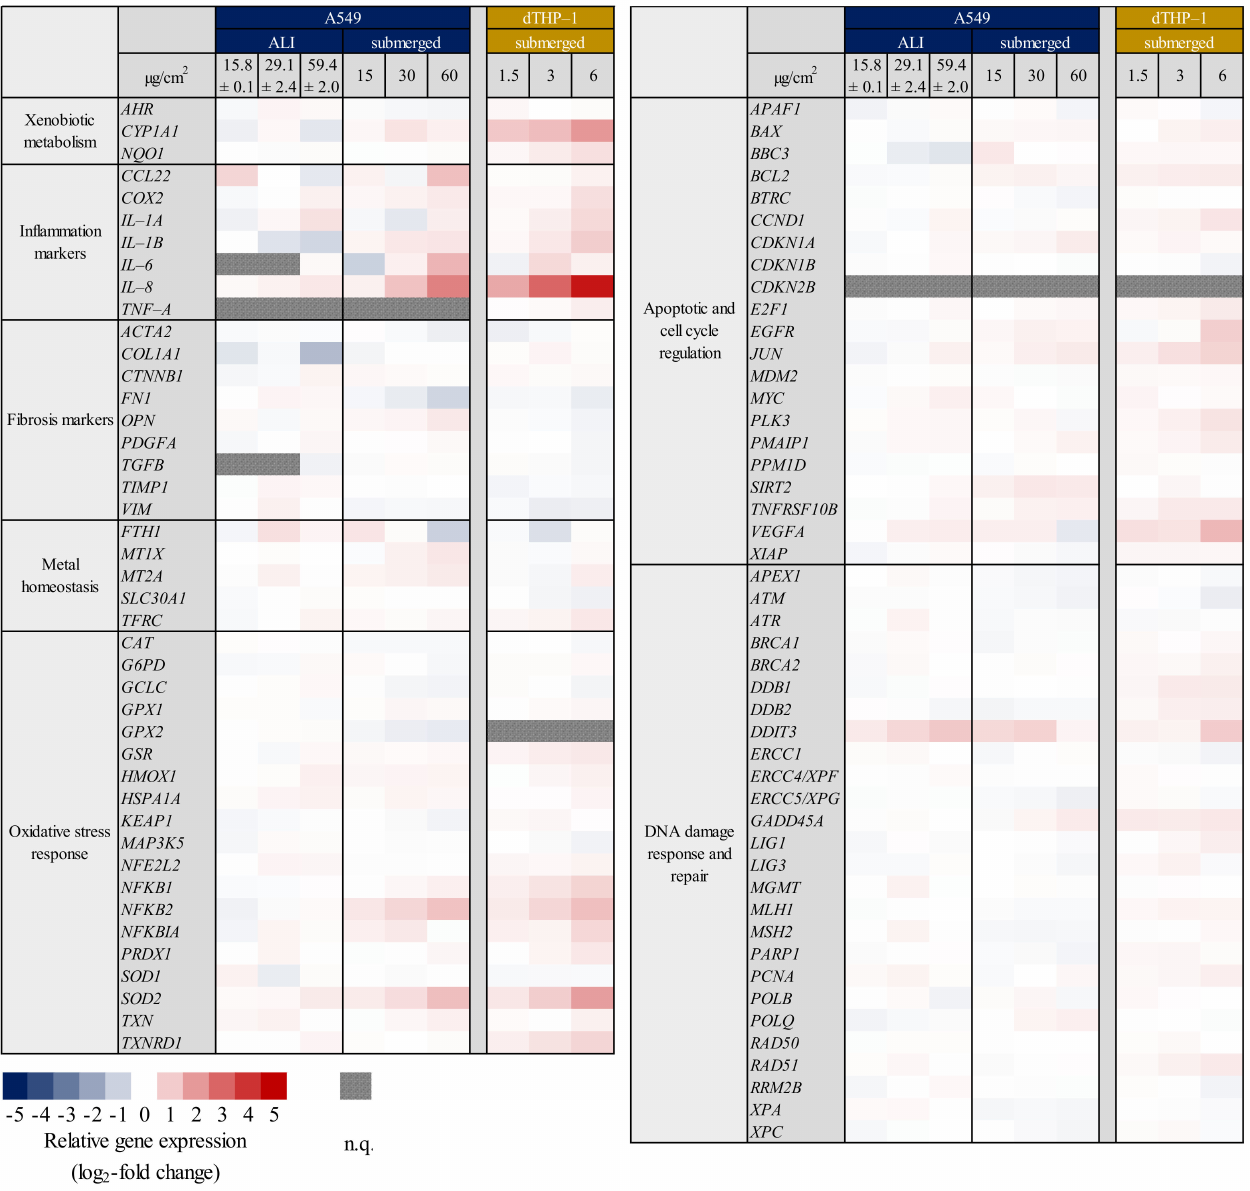
Figure 1. Gene expression profiles of A549 and dTHP-1 mono-cultures after air-liquid interface (ALI) and/or submerged exposure to Min-U-Sil5. A549 and dTHP-1 cells were exposed to three different doses of Min-U-Sil5 and incubated for 24 h. The results are depicted as the log 2 -fold change of the relative gene expression. A red color represents the induction, a blue color the repression of a gene. The means of at least three independent experiments are displayed. Applied doses in ALI exposures were calculated as means ± SD from three independent experiments. n.q.: not quantifiable due to low expression